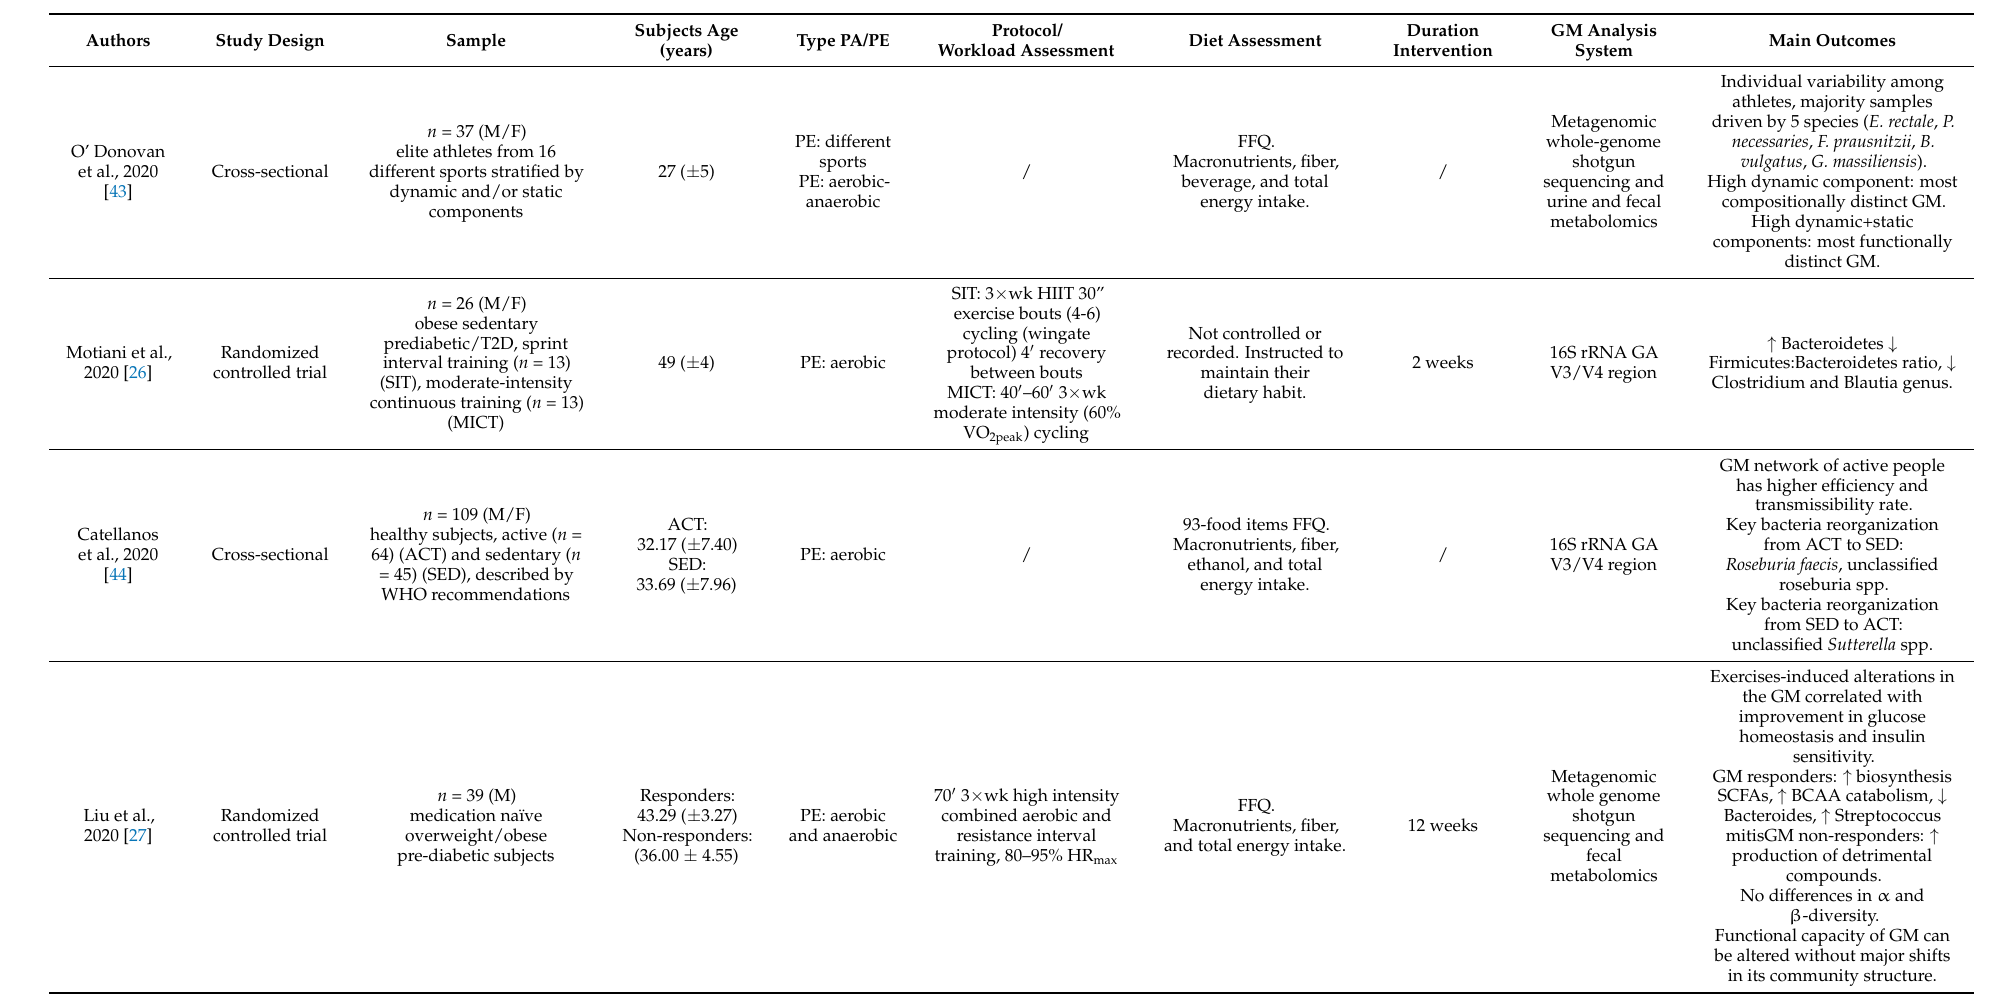
FFQ. Macronutrients, fiber,